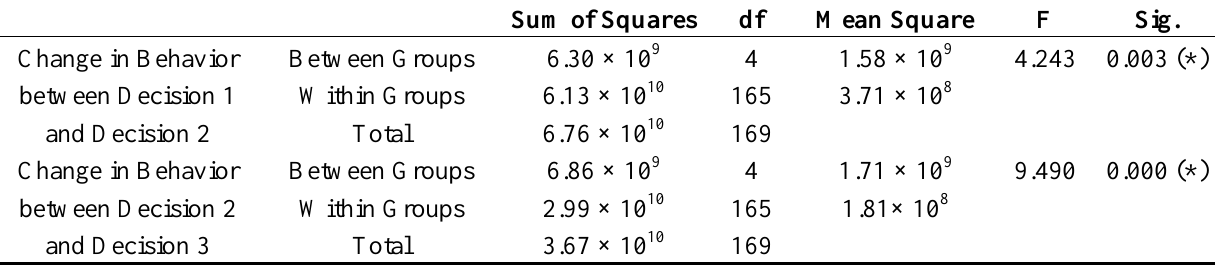
Table 7. One-Way ANOVA of Feedback Type Considering Value